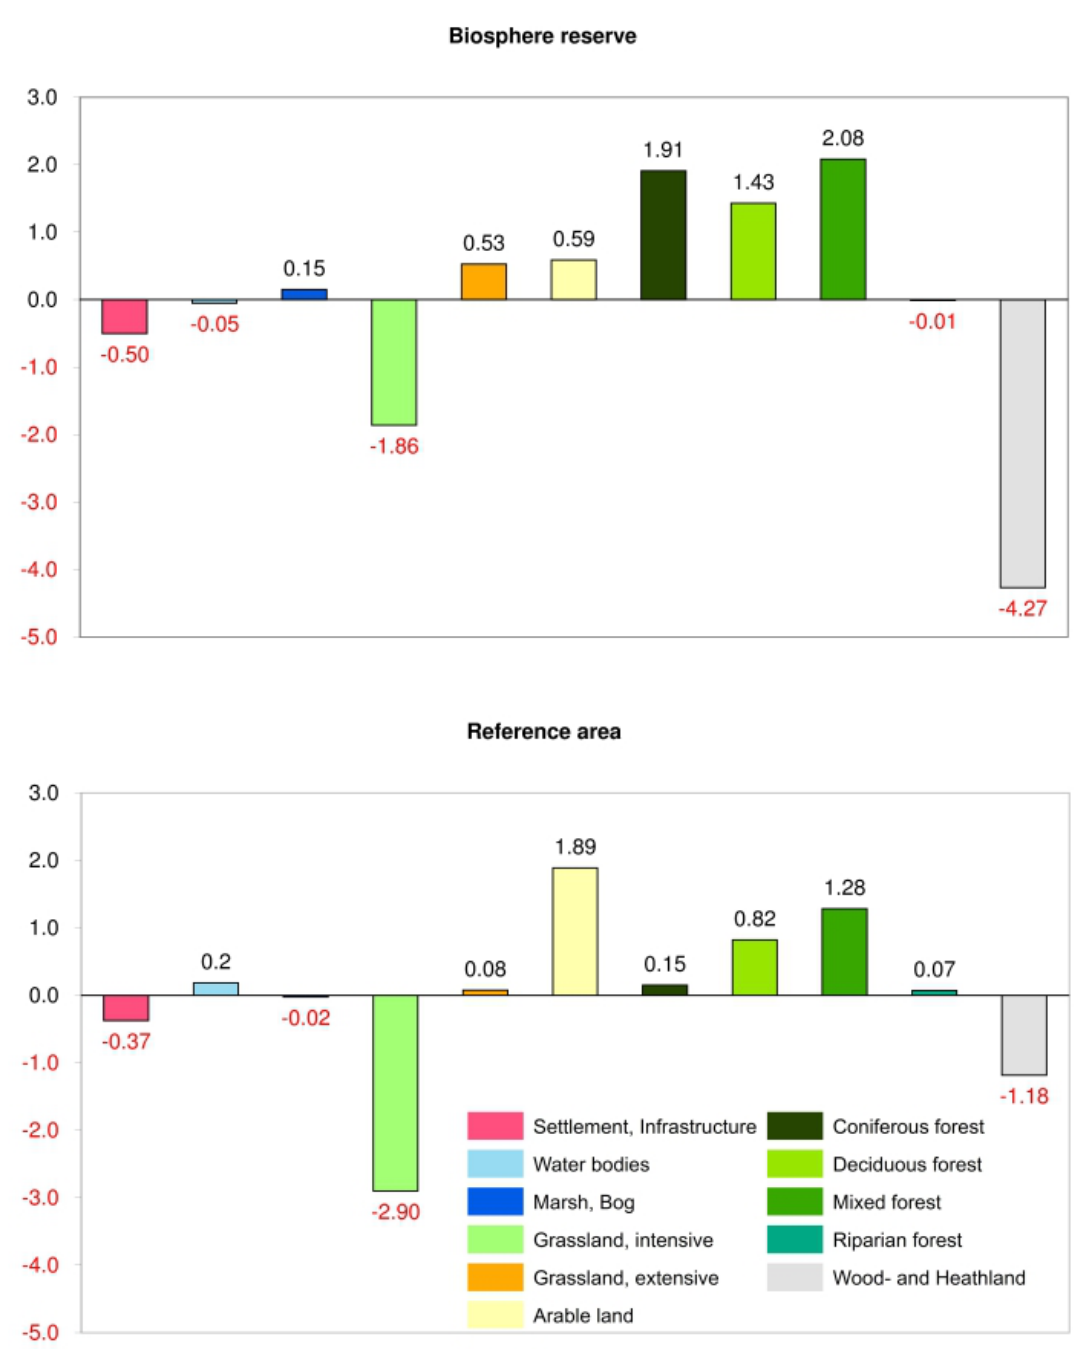
Fig. 3 . Net changes in land cover classes (% of landscape) between 1992 and